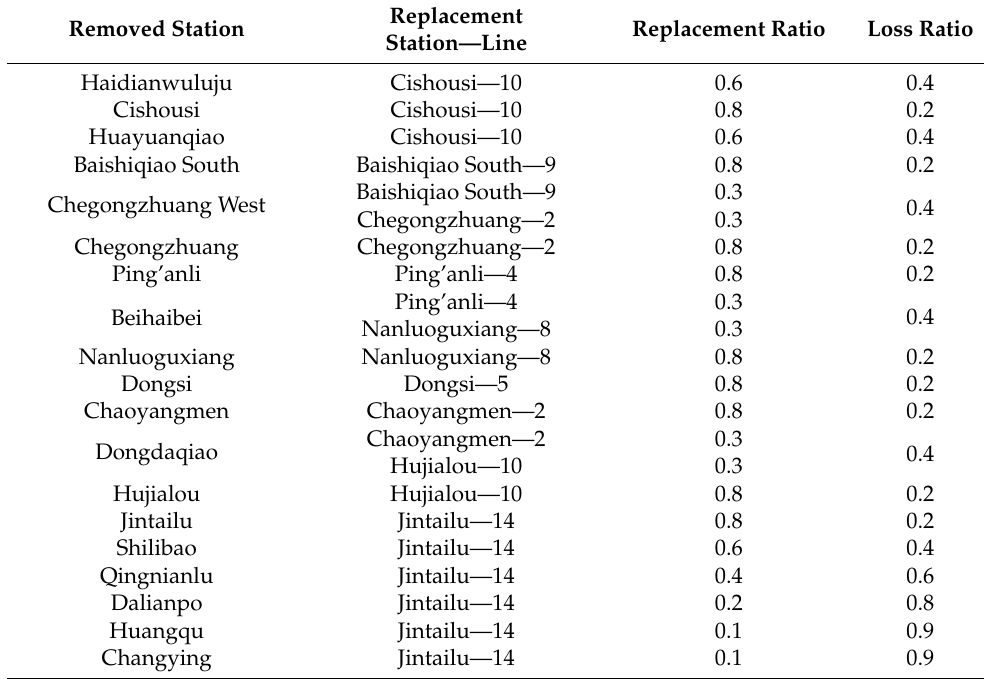
Table 2. Replacement station and proportion of passenger flow in Line 6.